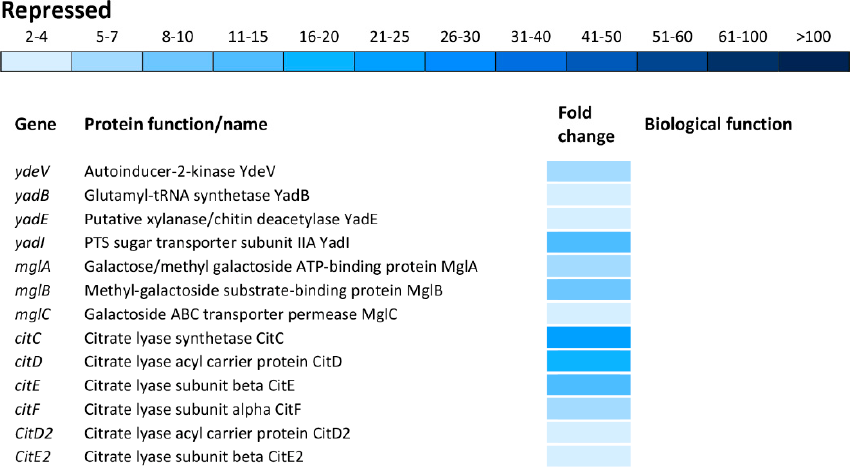
Figure 7. Differential expression of genes involved in amino acid and carbohydrate metabolisms. The mean fold-decrease in each gene expression after exposure to 3 mM of H 2 O 2 compared with controls is indicated by the color scale bar.